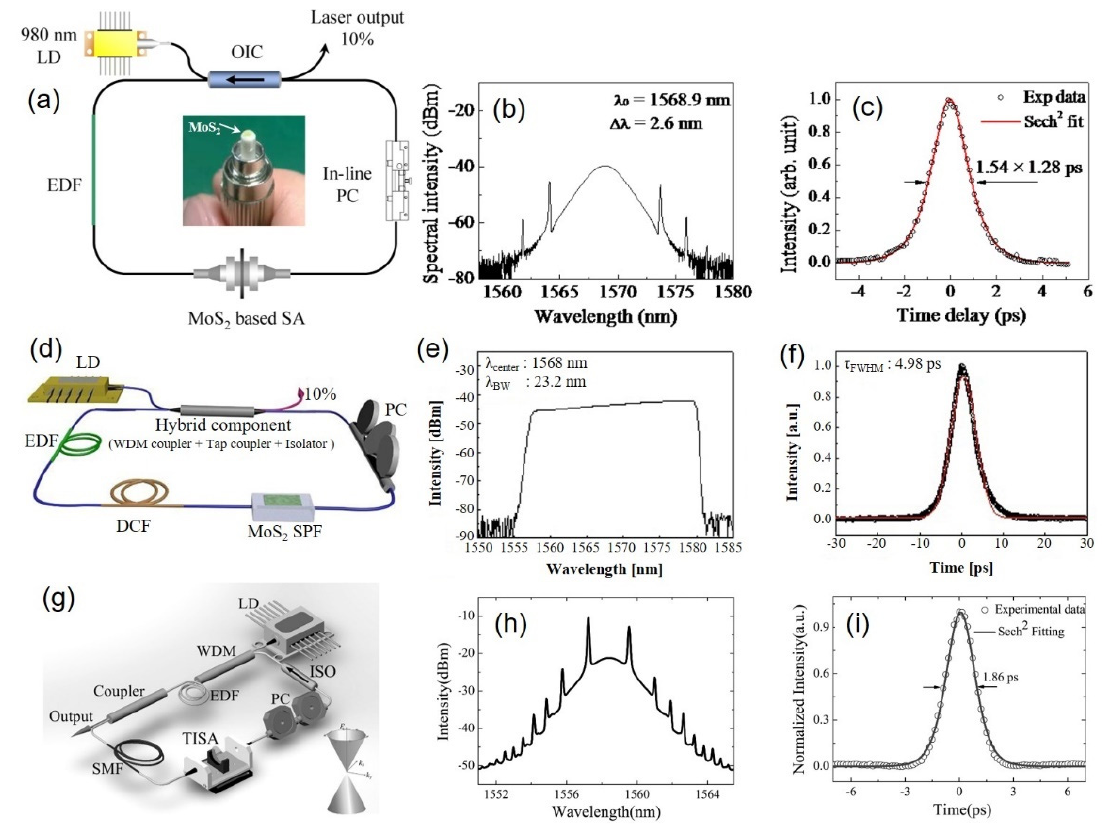
Figure 9. Mode-locked ultrafast fiber laser in the NIR region with various 2D SAs such as one of the TMDs named MoS 2 SA ( a – f ) and one of the TIs named Bi 2 Te 3 ( g – i ). ( a – c ) CS with MoS 2 SA: ( a ) A schematic diagram of the fiber ring laser in anomalous dispersion with MoS 2 SA sandwiched in between two SMF (inset: Photograph of a fiber connector coated with multilayer MoS 2 ); ( b ) Optical spectrum of conventional soliton mode-locked pulse with a bandwidth of 2.6 nm; ( c ) Autocorrelation trace with a Sech 2 fit showing pulse duration of 1.28 ps. ( a – c ) Reproduced with permission. Copyright 2014, The Optical Society [200]. ( d – f ) DS with MoS 2 SA ( d ) A schematic diagram of the fiber ring laser in normal dispersion with MoS 2 SA deposited on SPF. ( e ) The optical spectrum of the mode-locked laser at net cavity dispersion of +0.095 ps 2 and ( f ) Measured pulsed duration fitted with Gaussian pulse. ( d – f ) Reproduced with permission. Copyright 2014, The Optical Society [162]. ( g – i ) CS with Bi 2 Te 3 SA: ( g ) mode-locked fiber laser cavity comprising Bi 2 Te 3 SA, ( h ) mode-locked optical spectrum with 3 dB bandwidth of 2.69 nm, and ( i ) autocorrelation trace of mode-locked soliton pulse with the FWHM width of 1.86 ps. ( g – i ) Reproduced with permission. Copyright 2012, AIP [201]. SA in a passively mode-locked Er-doped fiber laser to achieve both soliton and